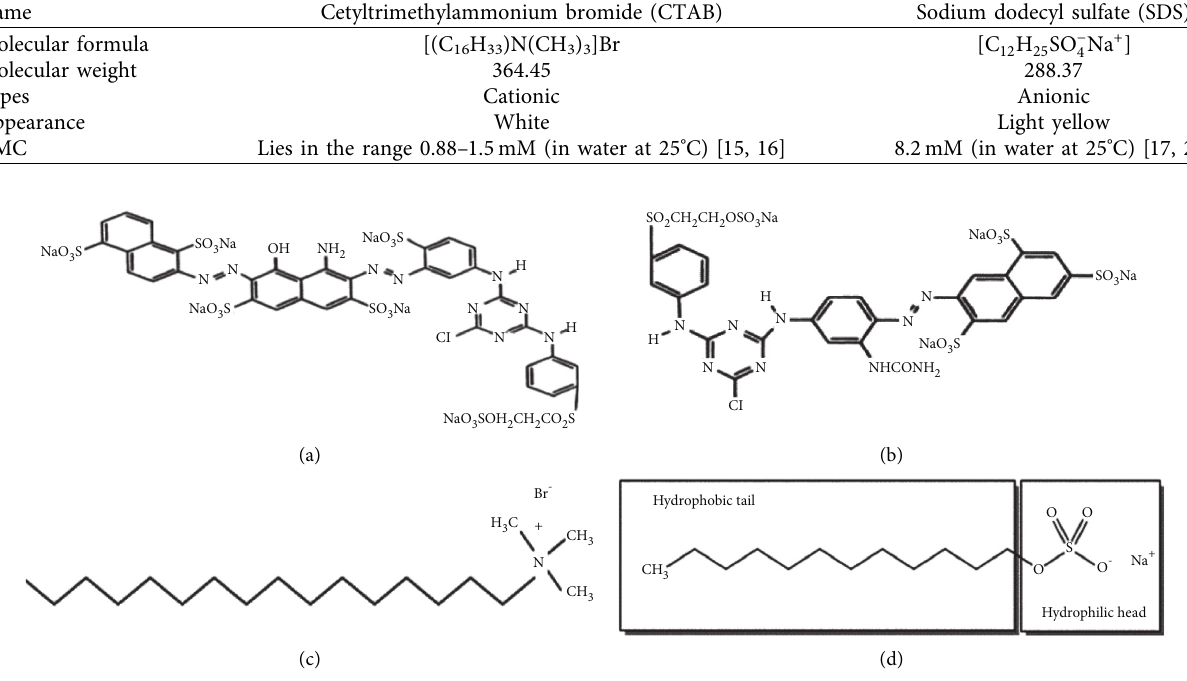
Figure 2: Chemical structures of ionic dyes (a) RB222, (b) RY145, (c) CTAB, and (d) SDS as surfactants.